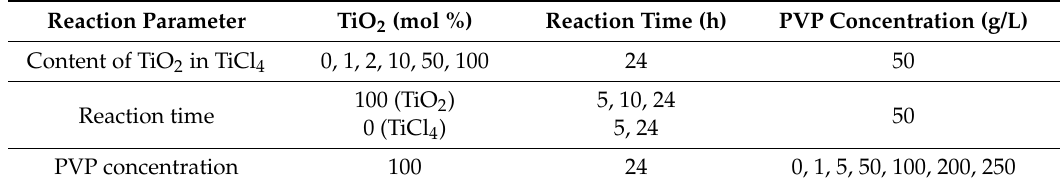
Table 1. Reaction conditions utilized during the BT-PVP synthesis in this study.